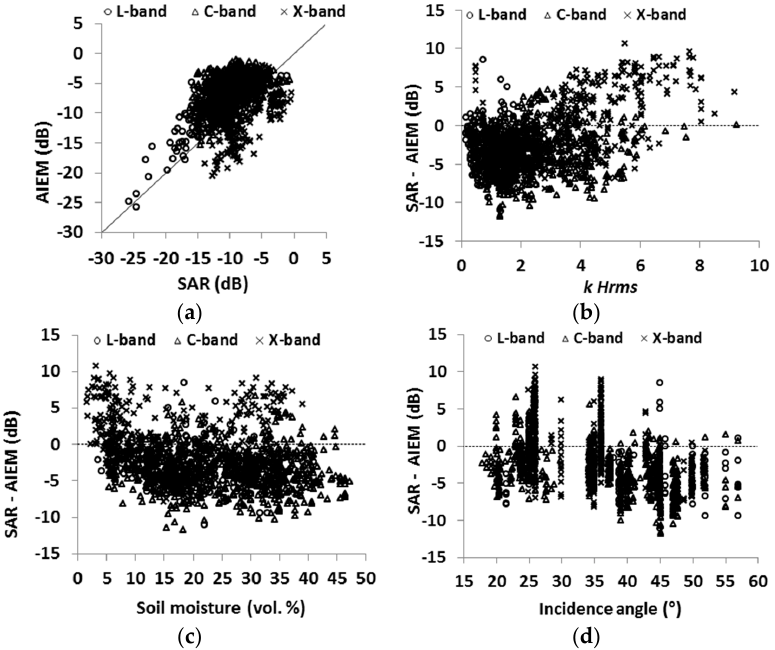
Figure 17. Comparison between backscattering coefficients derived from SAR images and those estimated from AIEM at HH polarization using ECF. ( a ) AIEM simulations vs. SAR data; ( b ) difference between SAR signal and AIEM vs. soil roughness ( kHrms ); ( c ) difference between SAR signal and AIEM vs. soil moisture ( mv ); ( d ) difference between SAR signal and AIEM vs. incidence angle.